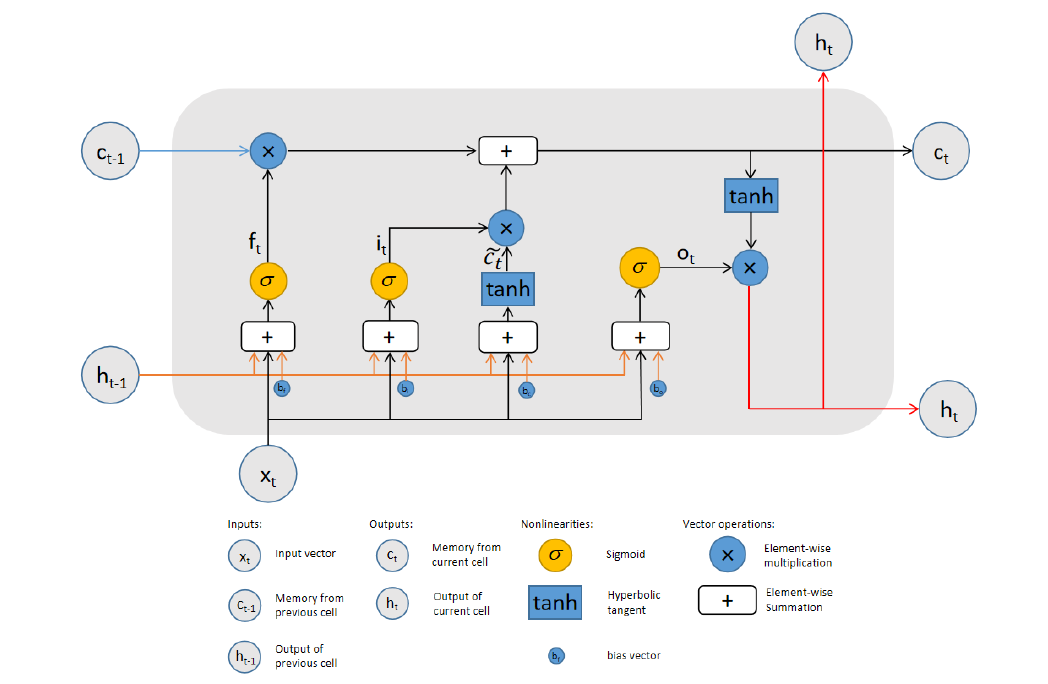
Figure 1. Schematics of an LSTM